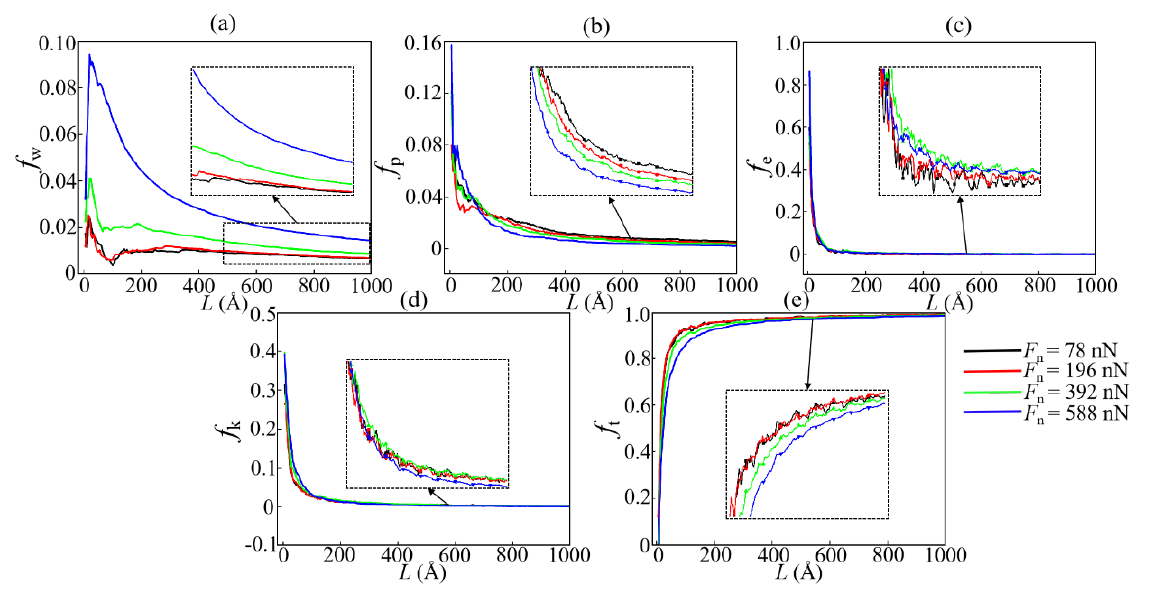
Figure 12. Evolution of the proportion of various energy dissipation forms under different F n at V x = 1 Å/ps, T = 300 K: ( a ) f w ; ( b ) f p ; ( c ) f e ; ( d ) f k ; ( e ) f t .